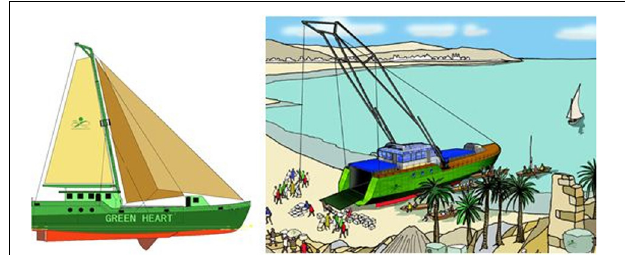
FIGURE 4 | S.V. Greenheart, 220t Sail/Solar Freighter (source: Greenheart